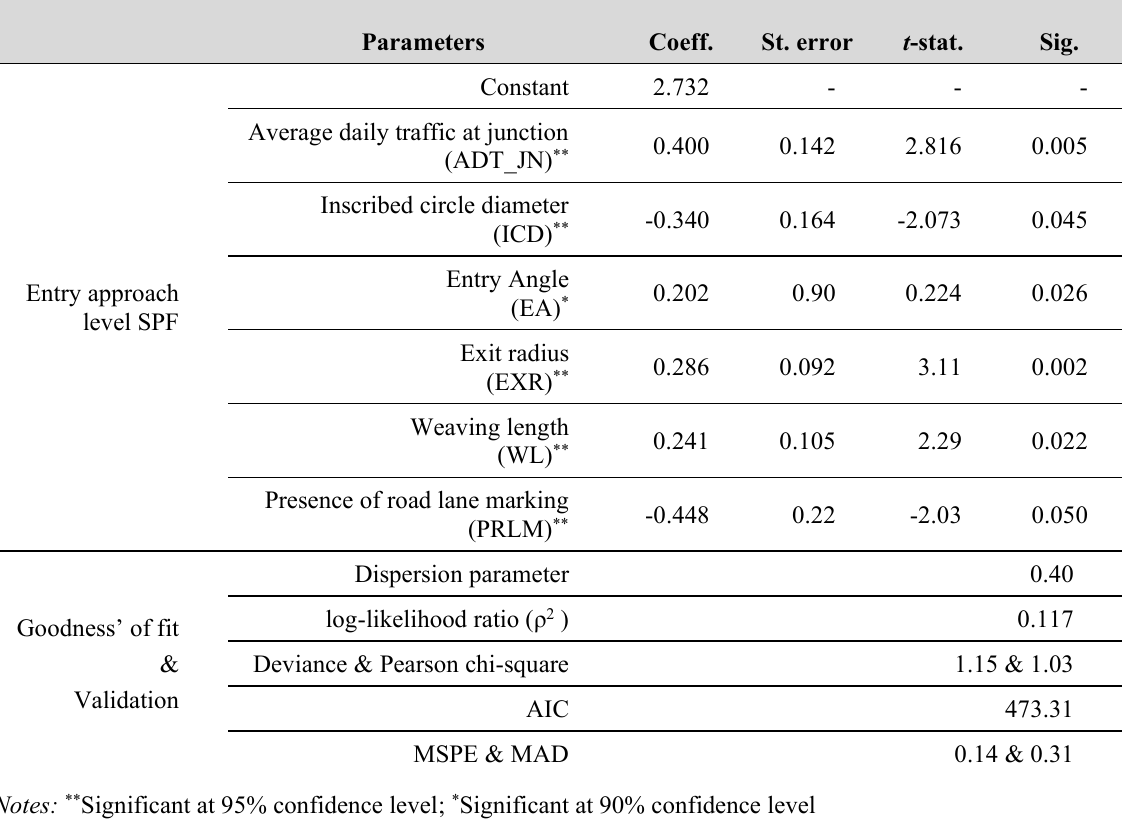
Table 2 Estimates of SPF model for entry